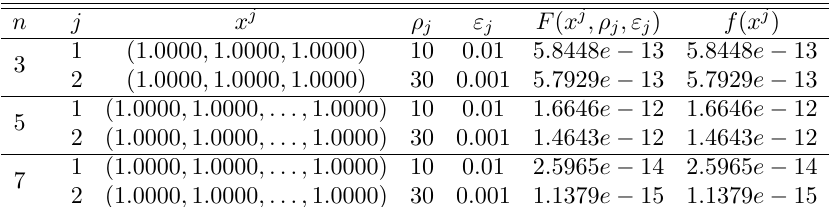
Table 6. Table of minimization process of the Problem 6.